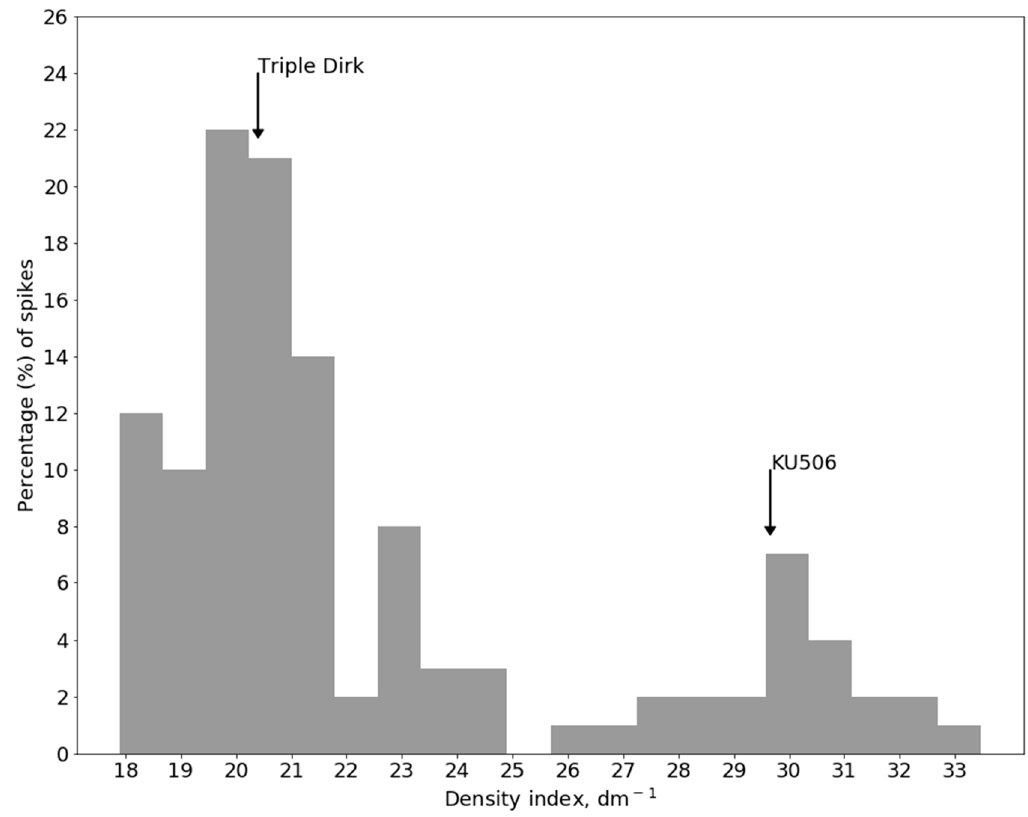
Figure 9. Distribution of the spike density values predicted using 2D images for the F 2 hybrids between a near-isogenic line of the Australian common wheat cultivar Triple Dirk (Triple Dirk B) and Chinese wheat Triticum yunnanense King ex S.L. Chen (syn. T. spelta ssp . yunnanense (King ex S.L. Chen) N.P. Gontsch.) accession KU 506. The X axis shows the density index and the Y axis is the percentage of spikes. Arrows point to the parent D values, amounting to 20.40 for Triple Dirk B and 29.66 for KU 506.